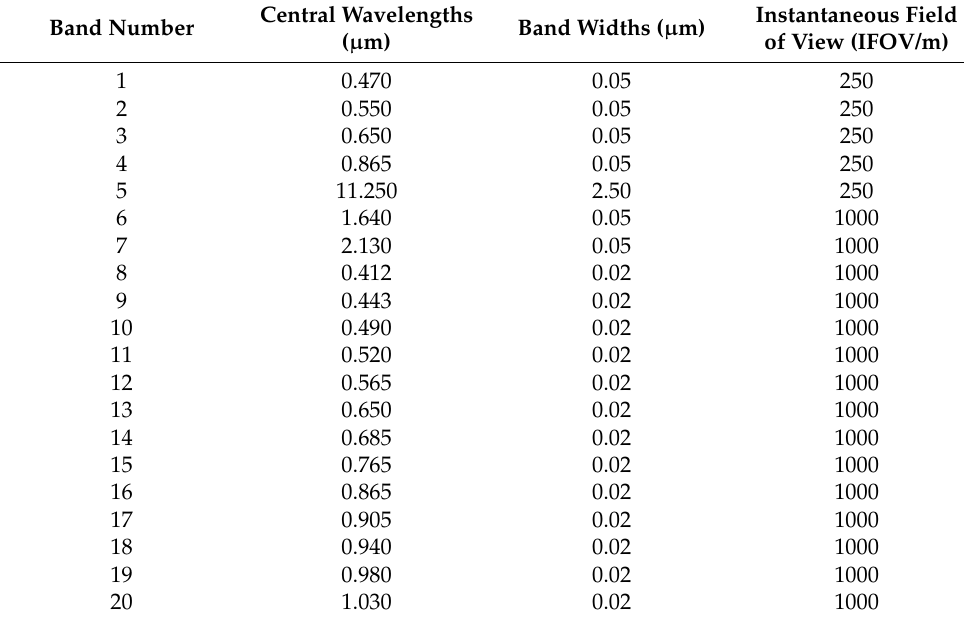
Table 2. Information on the FY-3B/MERSI spectral bands and specifications. Band